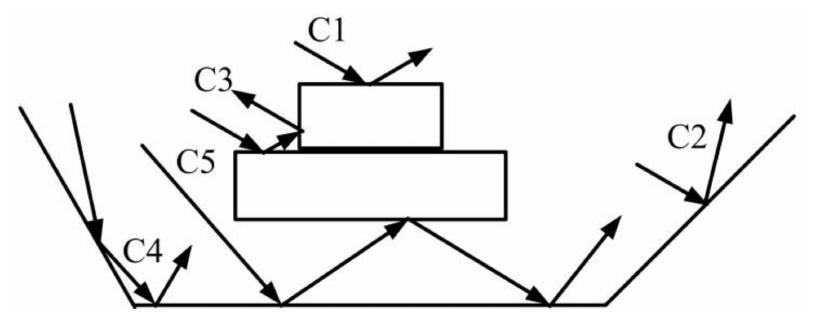
Figure 4. Illustration of SBR-FBSSA composite scattering model for canyon/valley